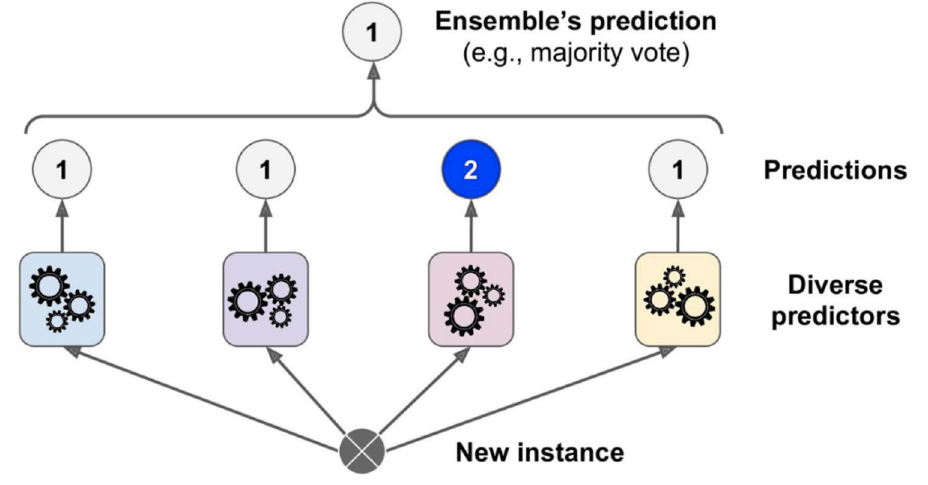
Figure 3. Hard voting classifier prediction.